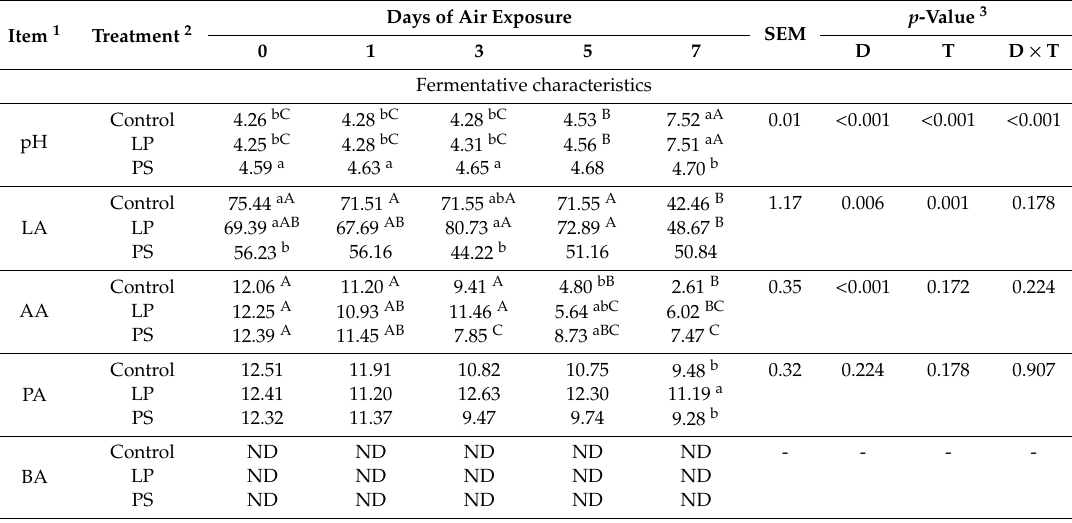
Table 5. Changes in fermentative characteristics and chemical compositions of TMR silages after exposure to